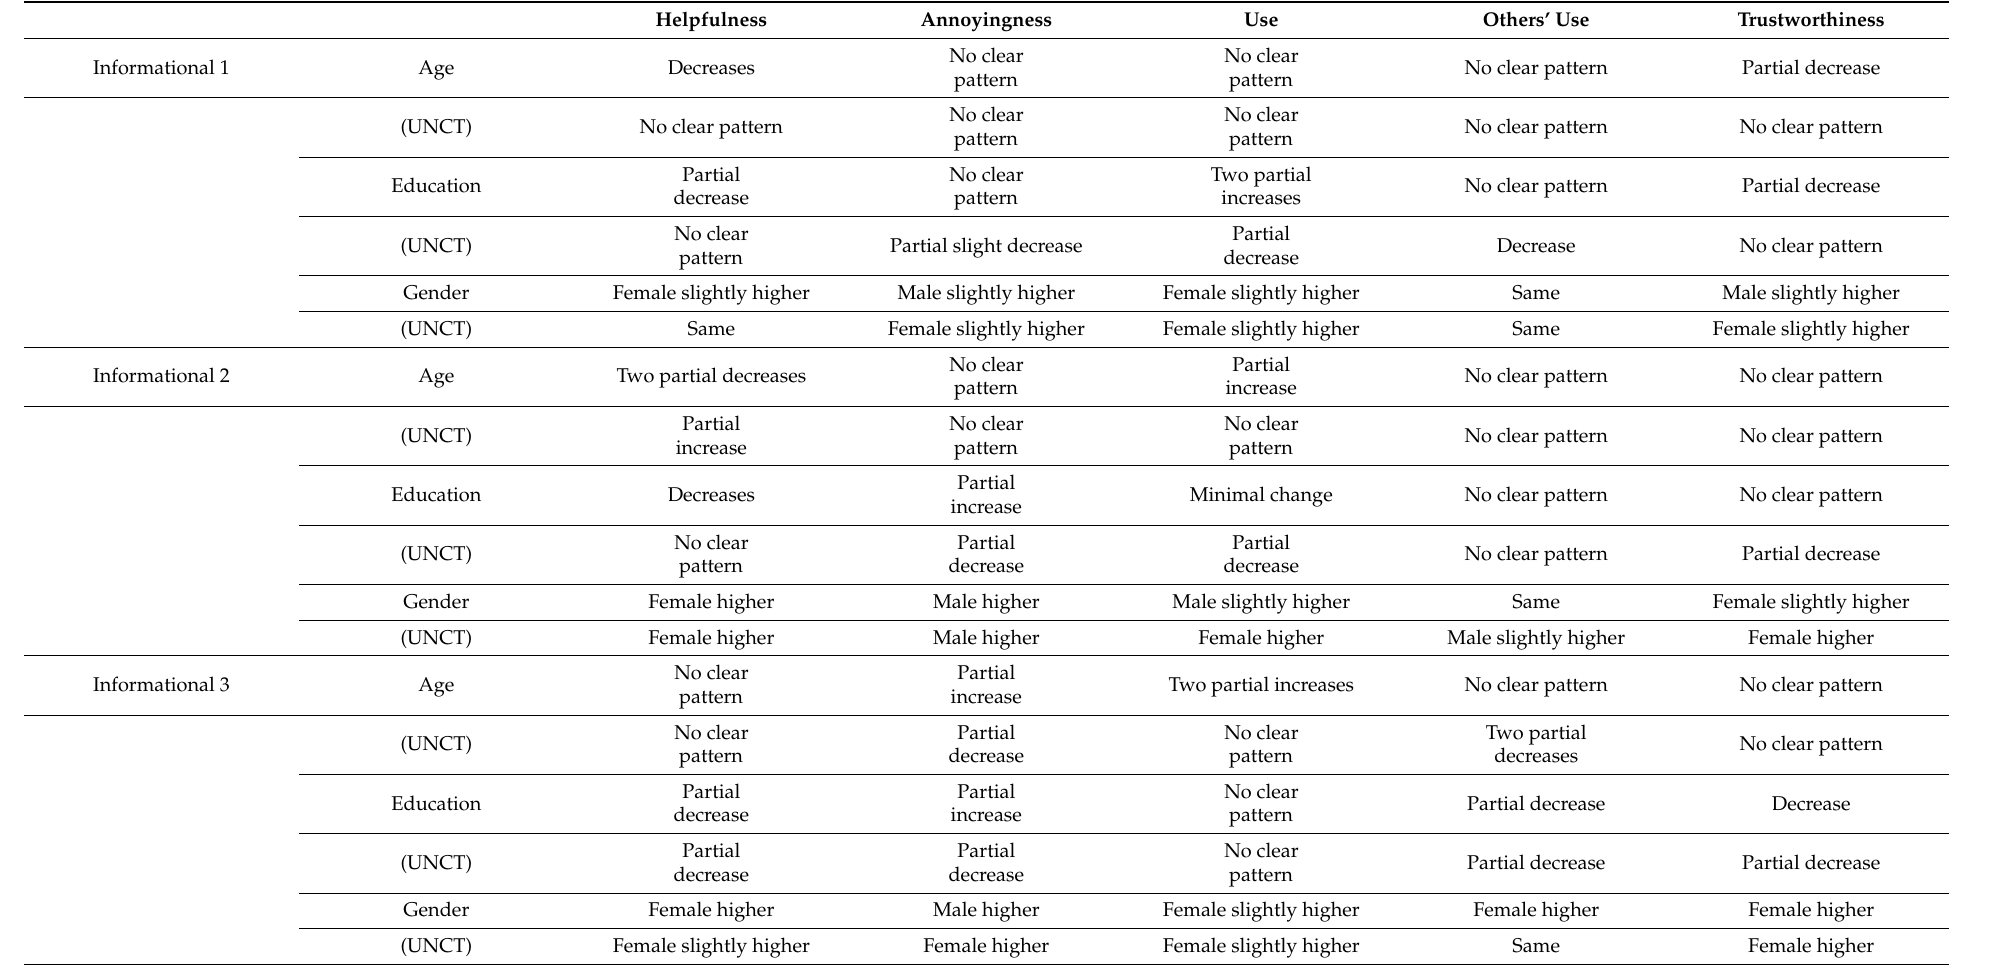
Table 4. Overview of trends in responses and respondents’